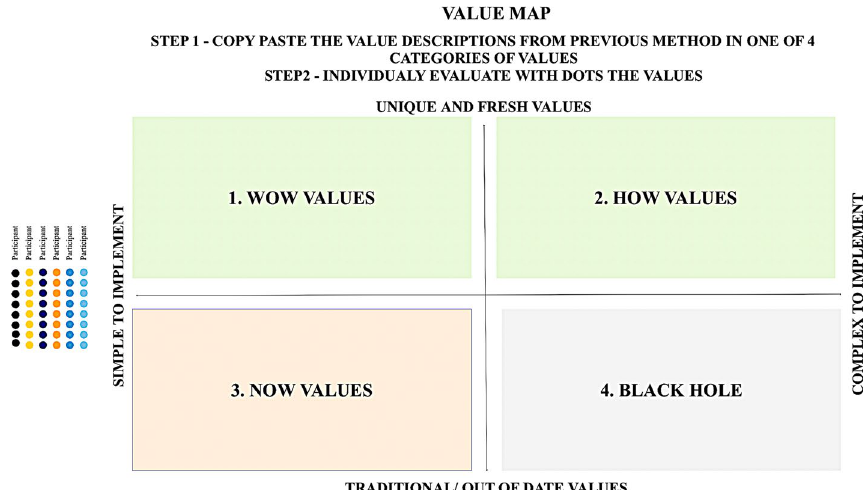
Fig. 8 Step 4 “Evaluate the values” of the 4‑step sequence of idea management to reinvent values (source: created by